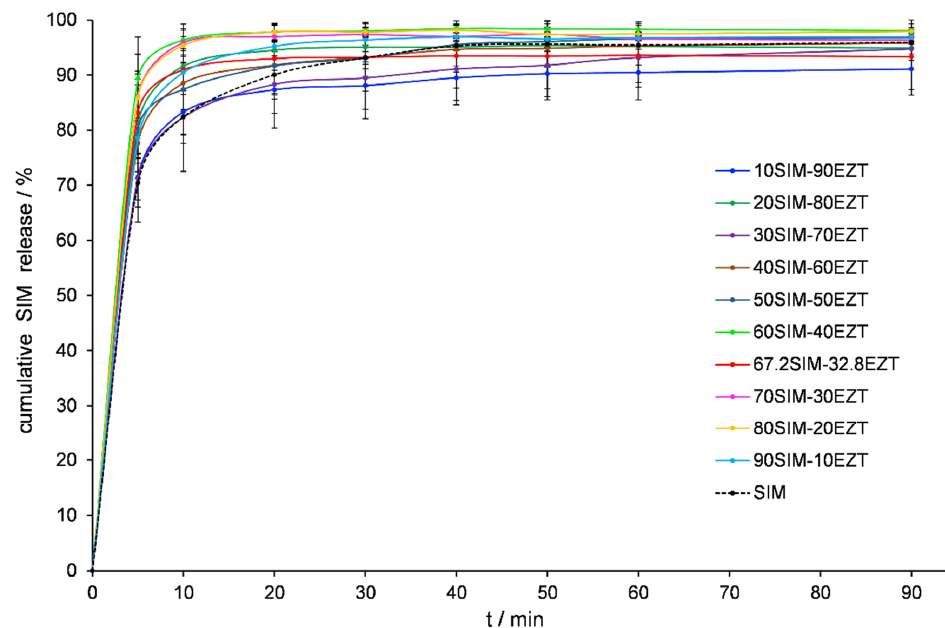
Figure 8. Dissolution profile of SIM released from SIM-EZT dispersions.